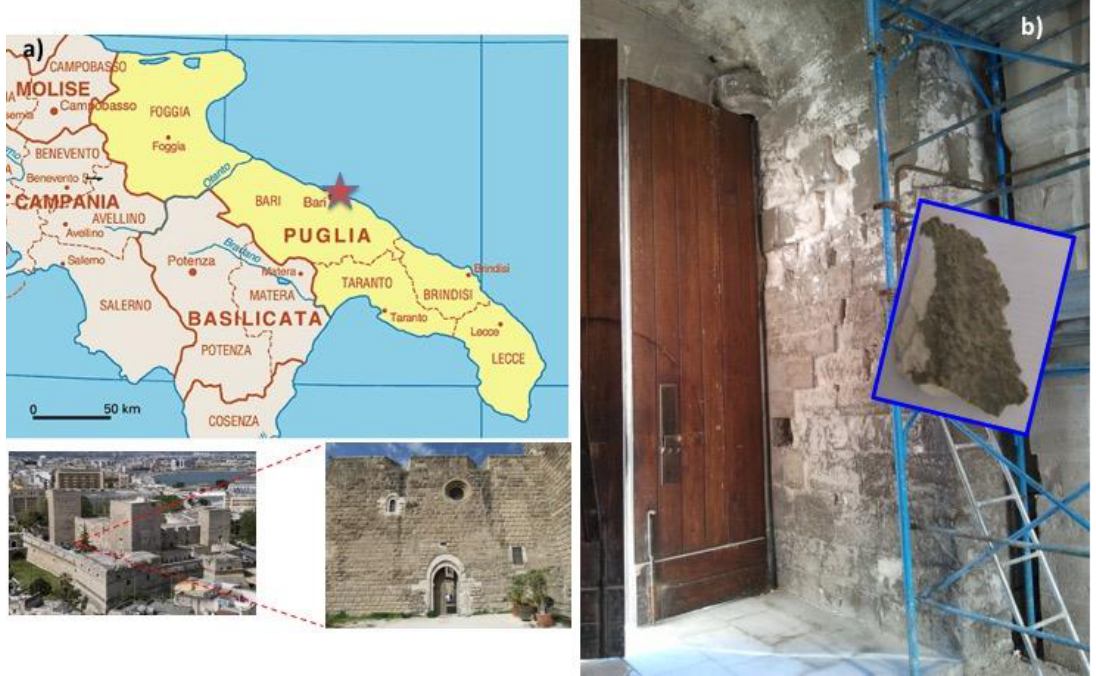
Figure 1. Map of south Italy indicating the city of Bari (red star), where the limestone masonry of Castello Svevo is located ( a ) and the internal castle wall from where the fragment studied (blue inset) was collected ( b ).